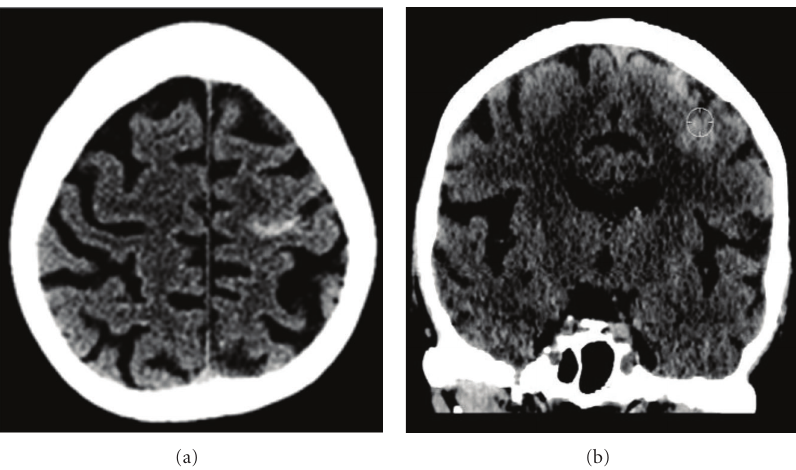
Figure 1: Unenhanced CT images of the brain. Axial and coronal CT images ((a) and (b)) of the brain in an 84-year-old normotensive female without history of trauma demonstrate a linear area of increased attenuation within the left frontal convexity, consistent with an isolated central sulcus hemorrhage.